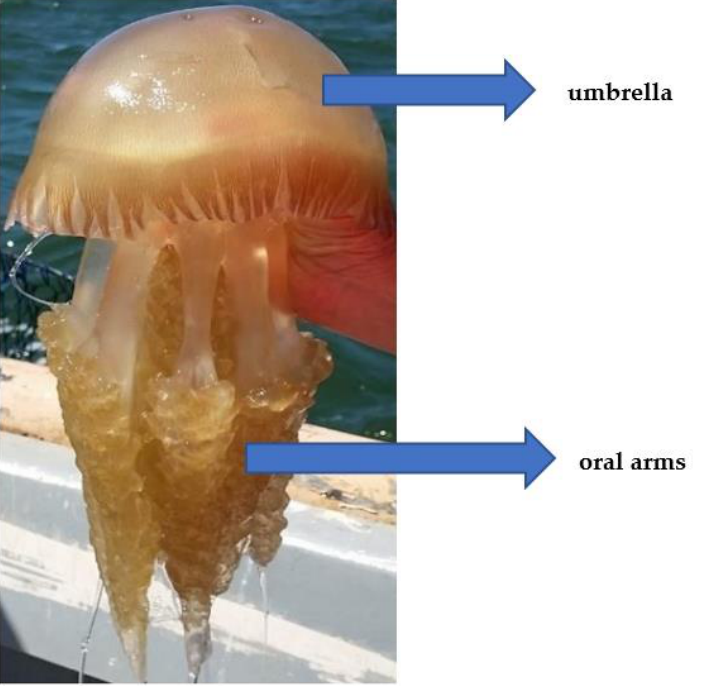
Figure 2. Photograph of jellyfish Catostylus tagi collected in the Tagus River. Edible portions (umbrella and oral arms) are pointed out.